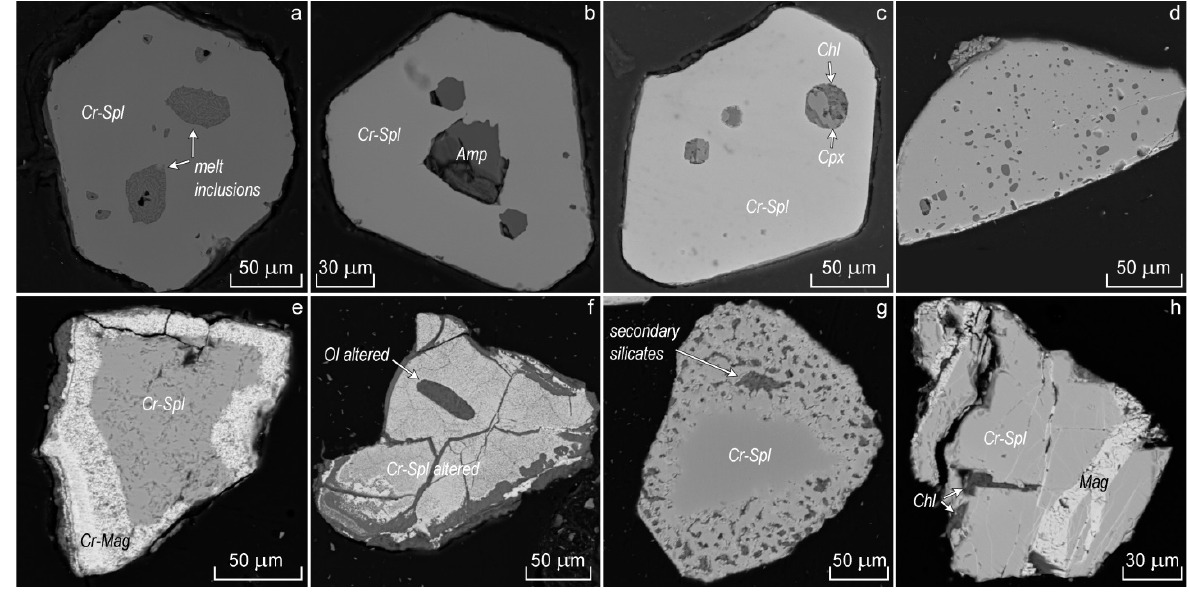
Figure 6. BSE-images of chromian spinels from Southern Pre-Ural paleoplacers: ( a – d )—different inclusions in chromian spinels (Sabantuy paleoplacer): ( a )—melt inclusions, ( b )—amphibole inclusions, ( c )—polymineral inclusions, ( d )—numerous olivine and orthopyroxene inclusions; ( e )—altered rim of chromian spinel grain (Kolkhoznyi Prud paleoplacer); ( f )—altered chromian spinel grain with altered olivine inclusion (Sukhoy Izyak paleoplacer); ( g )—altered rim (spongy texture) and solid core of chromian spinel grain; ( h )—altered chromian spinel grain with magnetite and chlorite veins (Novomikhaylovka paleoplacer). Amp = amphibole, Chl = chlorite, Cpx = clinopyroxene, Cr-Mag = chrommagnetite, Cr-Spl = chromian spinel, Mag = magnetite, Ol = olivine. Table 2. Average chemical composition of chromian spinels from different morphogroups in all studied